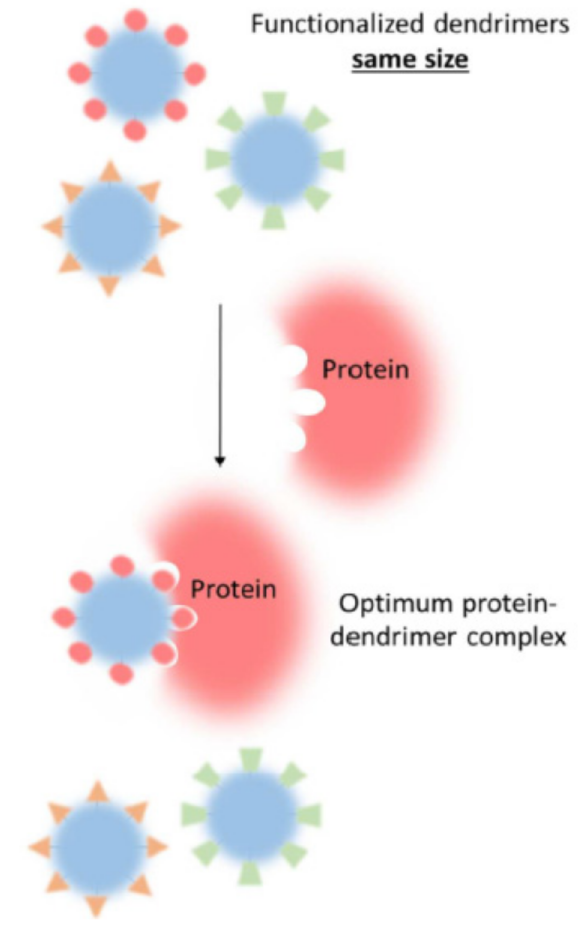
Figure 1. Schematic representation showing how terminal functionality is important with respect to optimum protein binding and selectivity. Reprinted with permission from ref. [28]. Copyright 2017, American Chemical